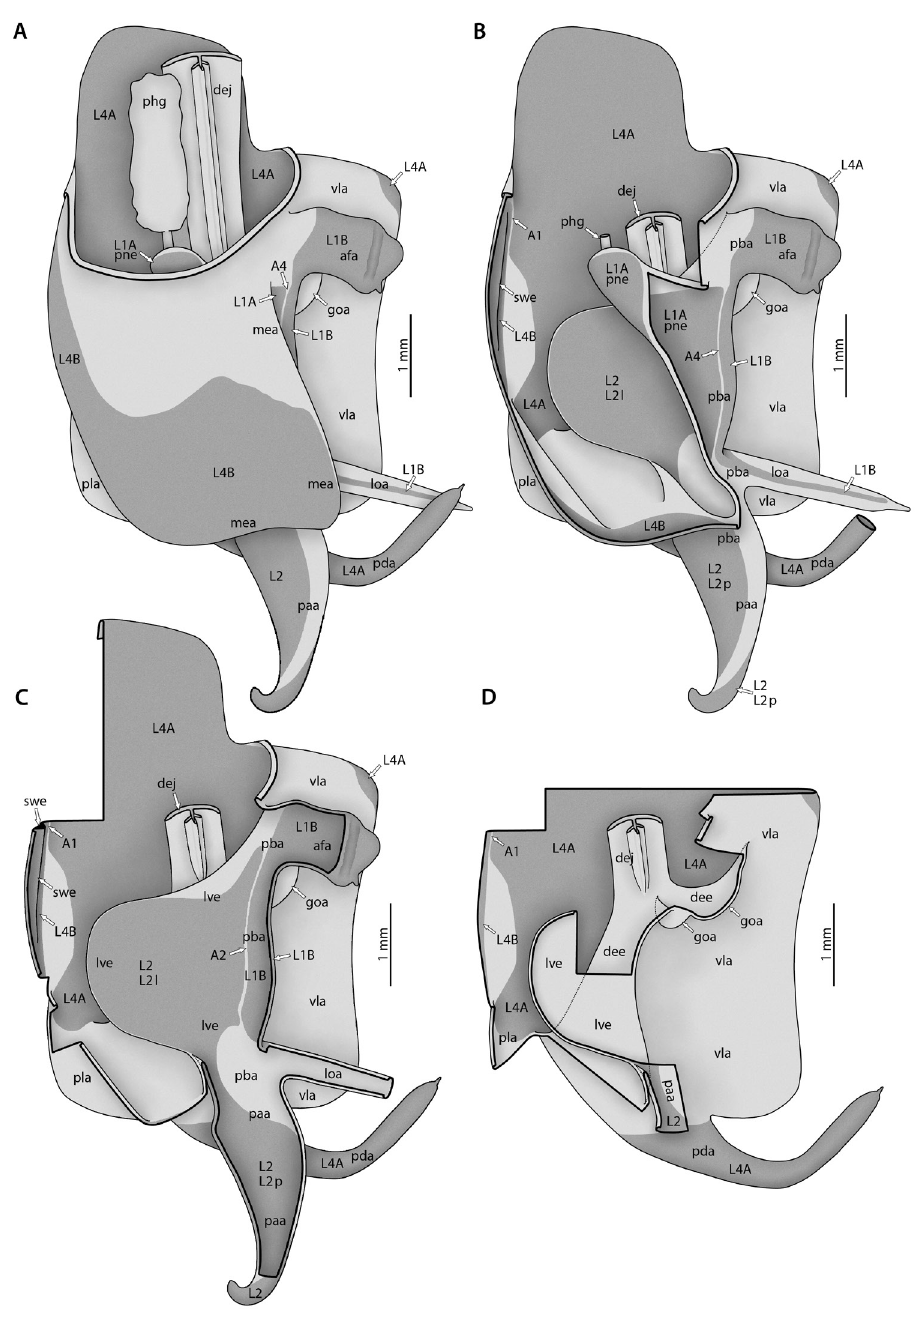
Figure 10. Continued. Dashed thin black lines are (parts of) edges hidden beneath other cuticle. Mem- branous cuticle in very light gray, sclerotized cuticle in darker gray; cuticle shaded darker where it goes under- neath other cuticle. For abbreviations see text, glossary, or Suppl. material 2: Extended abdominal